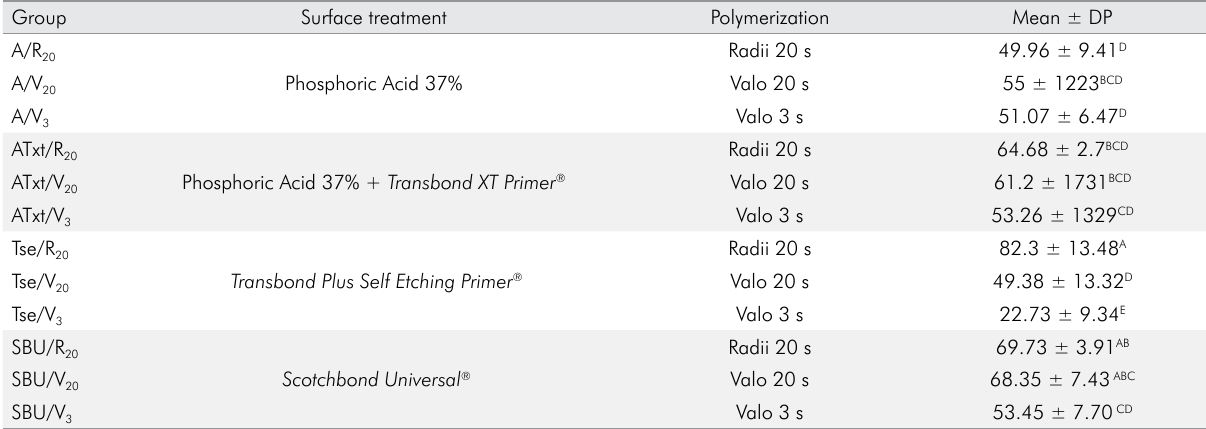
Table 6. Degree of conversion (%) according to the factors “surface treatment” and “polymerization” (n = 10). Group Surface